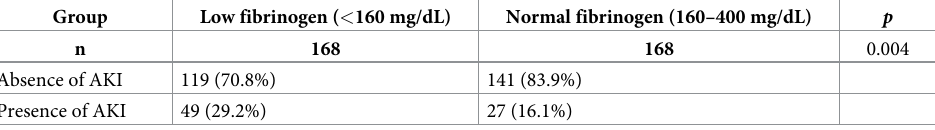
Table 2. The incidence of postoperative AKI according to fibrinogen